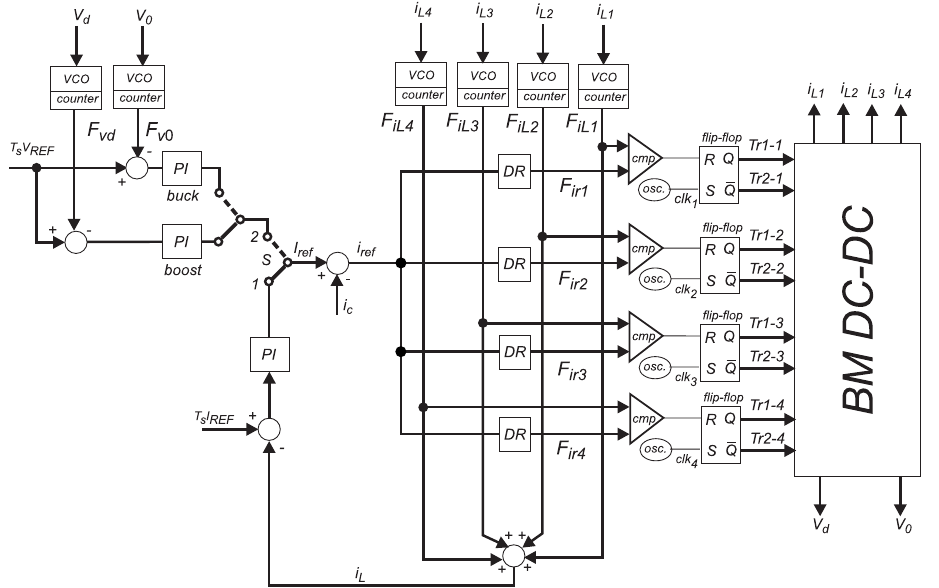
Figure 6. Detailed current and voltage control scheme; the current modulator with Dynamic Reference and Compensating